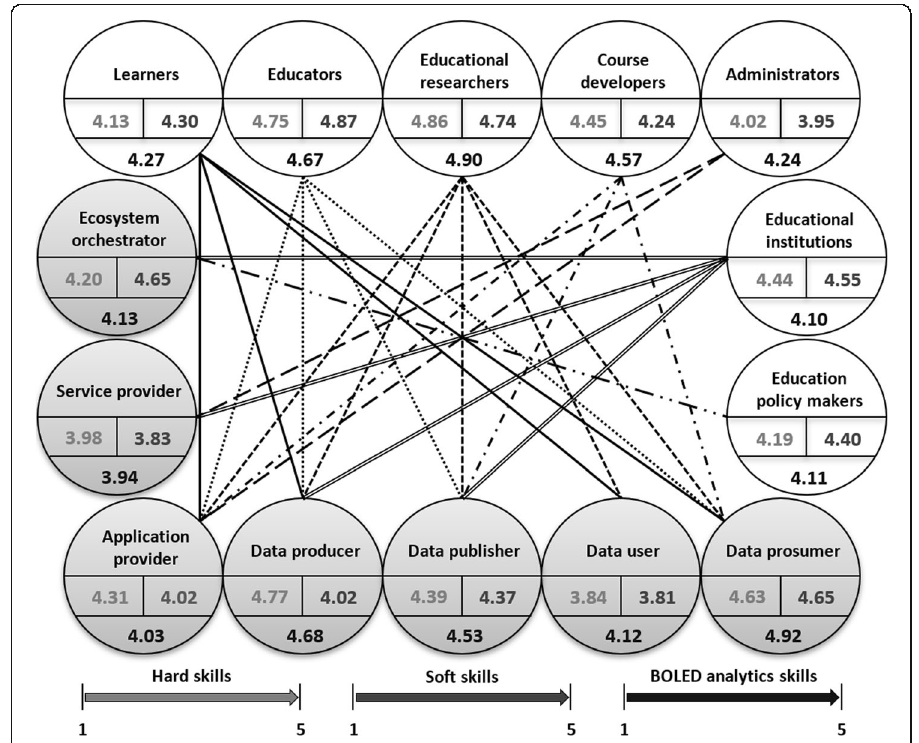
Fig. 10 Mapping the required skills on roles through their relationships by Likert scale (from 1 = extremely unimportant to 5 = extremely